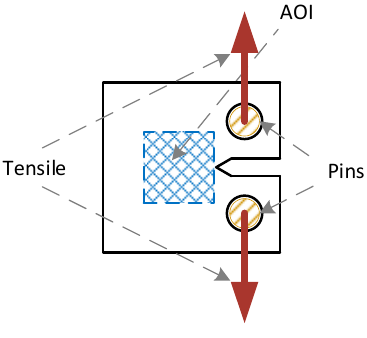
Figure 8. Strain distribution AOI.